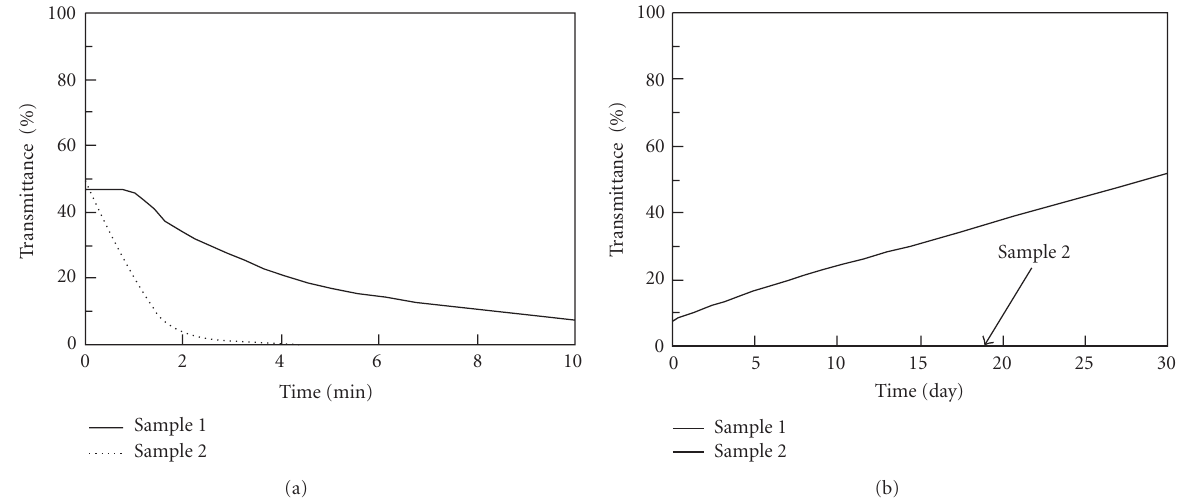
Figure 2: Time dependence of the transmittance of the films with (Sample 2) and without (Sample 1) CuCl 2 , at 420 nm wavelength. (a) shows the darkening property. (b) shows the fading property.